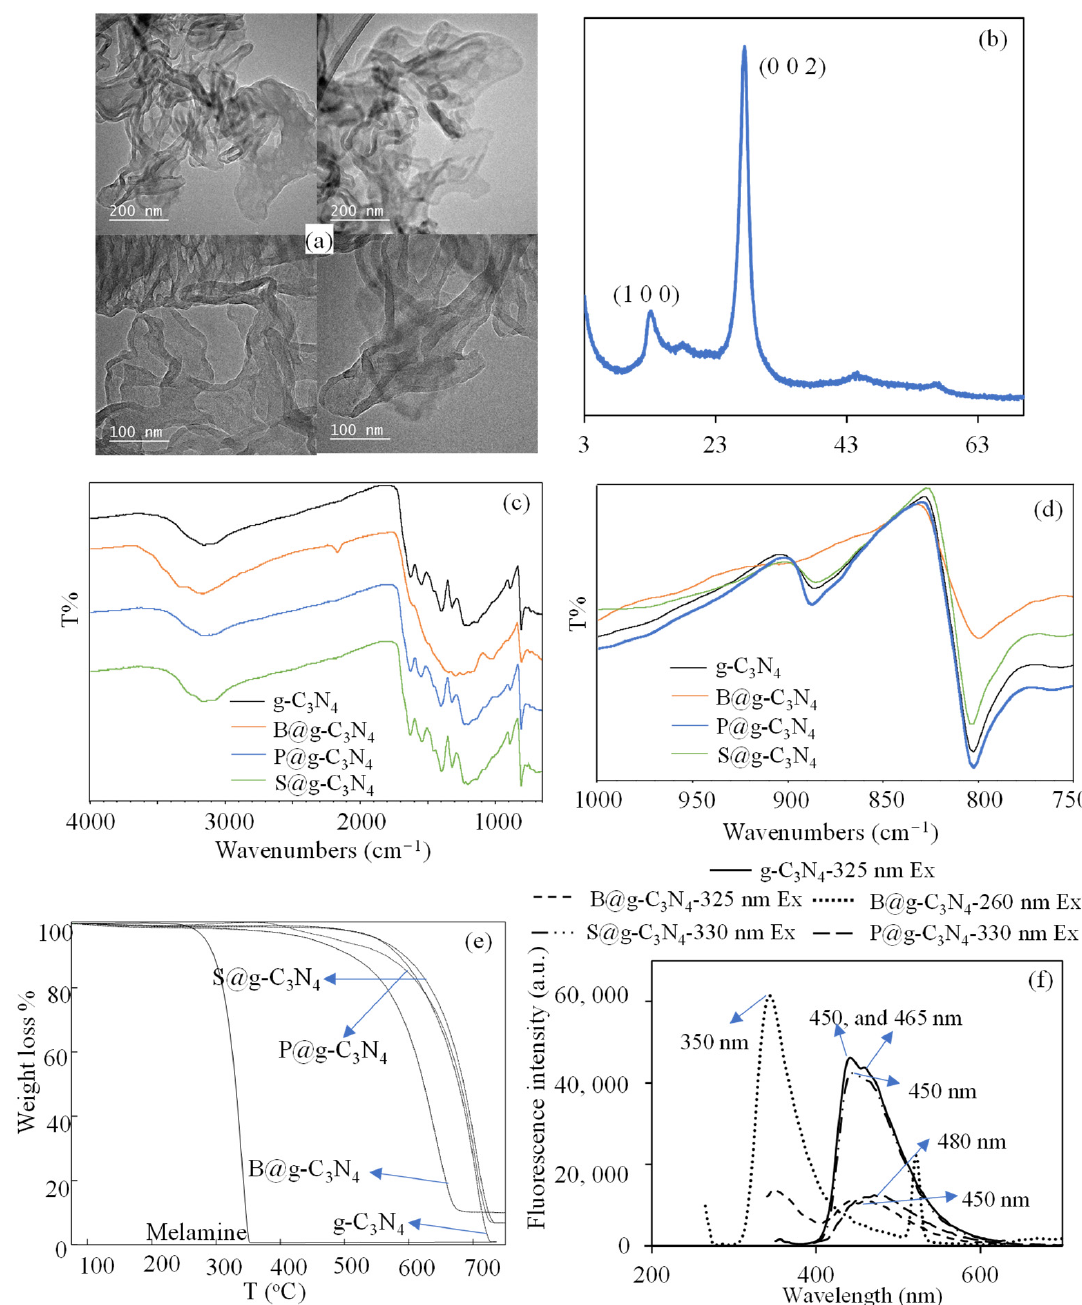
Figure 2. The ( a ) TEM images, ( b ) XRD pattern, ( c ) FT-R spectra, ( d ) detailed FT-IR spectra, ( e ) TGA thermogram, and ( f ) fluorescence spectra of g-C3N4-based structures.